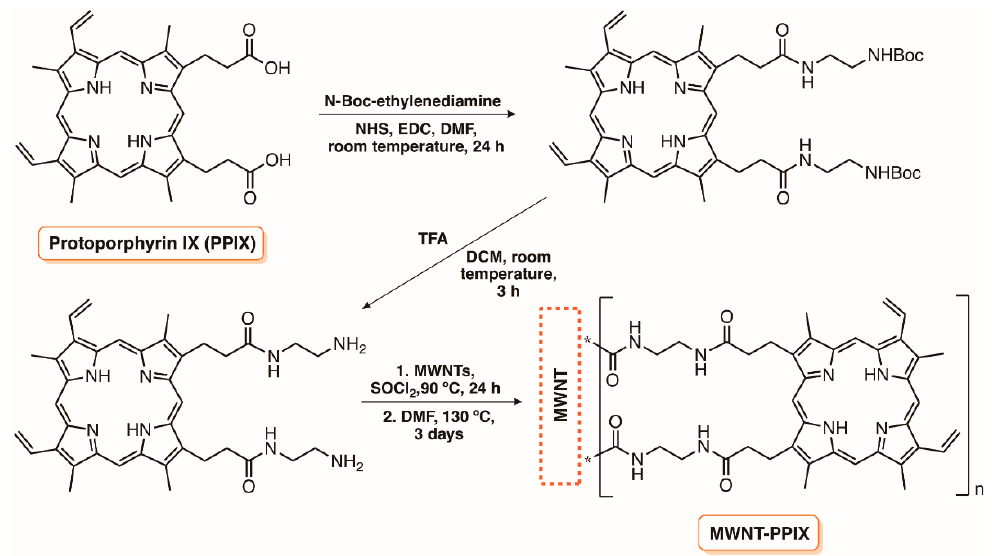
Figure 36. Functionalization of MWNT with PPIX (adapted from Reference [191]).